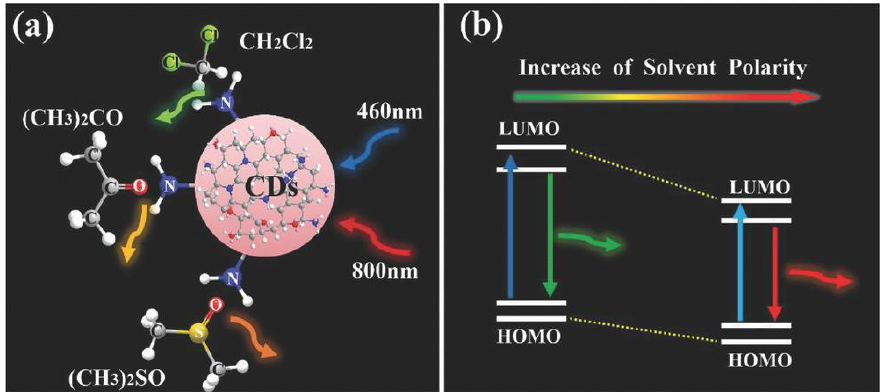
Figure 9. Schematic illustration showing the mechanism of multicolor emission from CDs. ( a ) The intermolecular interaction between solvent and CDs. ( b ) The change in energy levels of the CDs in different polarity solvents. (Reprinted from [112]; with the permission of John Wiley and Sons).